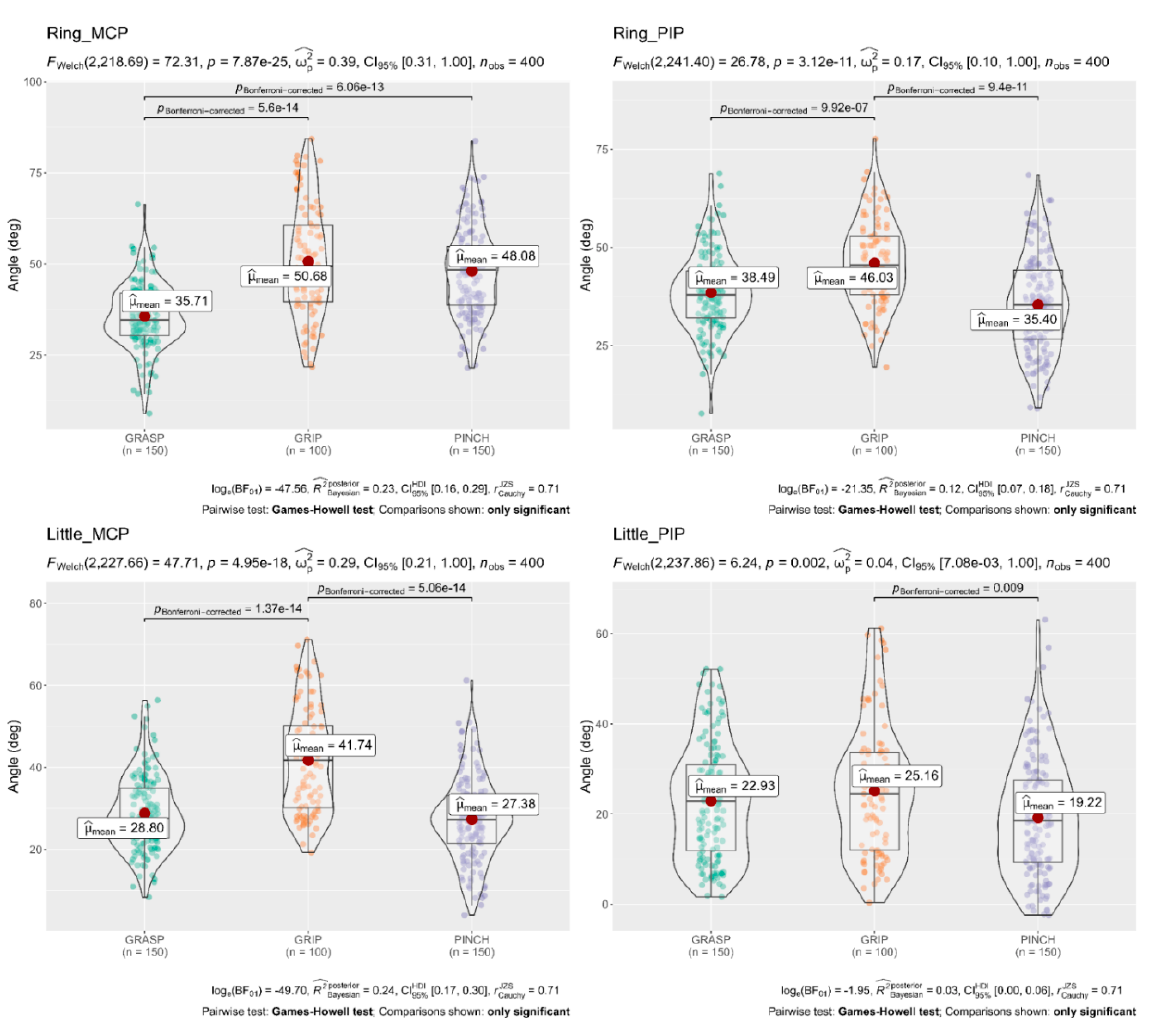
Figure 6. Welch’s ANOVA and Post hoc results; Comparison of flexion angles of the Ring and Little joints concerning the three Subscales of the ARAT. The flexion angles of the metacarpophalangeal (MCP) and proximal interphalangeal (PIP) joints of the Ring finger were significantly larger ( p < 0.05 each) in the grip subscale than in the grasp subscale. On the other hand, the flexion angles of the metacarpophalangeal (MCP) and proximal interphalangeal (PIP) joints of the Little finger were significantly larger ( p < 0.05 each) in the grip subscale than in the pinch subscale. Horizontal lines indicate significant differences ( p < 0.05, Games–Howell test post hoc comparison); deg =